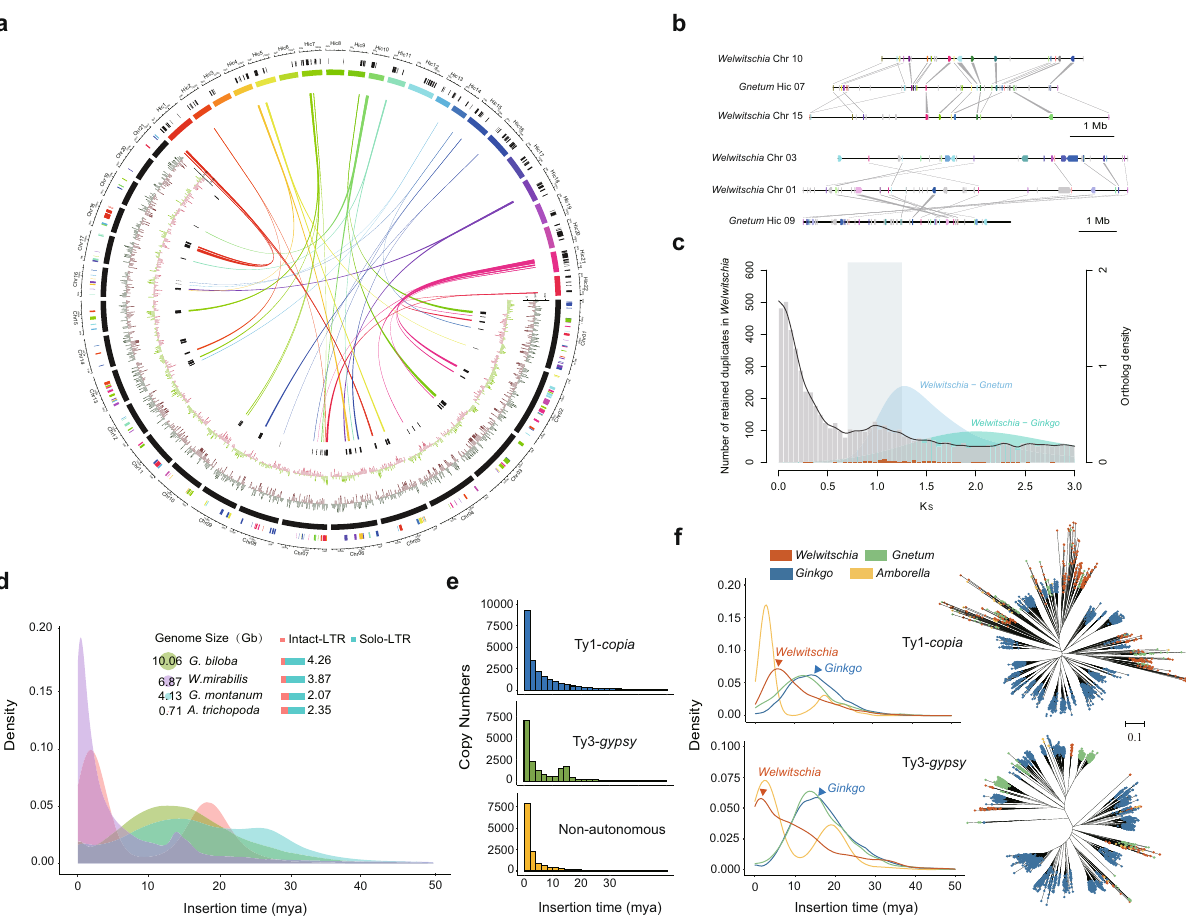
Fig. 2 Genome evolutionary history of Welwitschia . a A circos plot showing the inter-genomic collinearity analysis between the Welwitschia and Gnetum genomes. From outside to inside, each track shows (1) one-to-one orthologous collinear regions between the two genomes with colors showing their orthologs on different chromosomes in the other species; (2) the chromosomes of Welwitschia in black and Gnetum in colors; (3) the coverage of tandem repeats in a 5 Mbp window with green and red bars showing above or below the mean coverage of tandem repeats across the genome for Welwitschia (standard deviation in gray), respectively; (4) the coverage of long terminal repeats (LTRs) in a 5 Mbp window with light green and light red bars showing above or below the mean coverage of tandem repeats across the genome (standard deviation in gray), respectively; and (5) paralogous collinear regions in the Welwitschia genome with at least fi ve anchor pairs. The bands denote collinear regions where one region in Gnetum corresponds to two orthologous regions in Welwitschia . b Two examples illustrating one segment in Gnetum corresponding to two paralogous segments in Welwitschia . Genes in light gray are non-homologs. Genes with the same colors are homologs and homologous genes are connected with dark gray bands when the two segments are alongside. c Distributions of synonymous substitutions per synonymous site ( K S ) for the whole paranome of Welwitschia (light gray histogram and dark gray line). The y axis on the left shows the number of retained duplicates and there is a small peak at K S of 1, which represents a WGD event. The y axis on the right shows the orthologue density between the two species. For one-to-one orthologs between Welwitschia – Gnetum and Welwitschia – Ginkgo (color- fi lled curves of kernel-density estimates) the peaks represent species divergence events and K S values correspond with the degree of orthologue divergence. The K S values for anchor pairs from collinear regions are indicated in orange (left y axis). The pale gray rectangle highlights the K S regions in which the paralogous genes were used for absolute dating. d Estimation of LTR activity showing a recent burst in Welwitschia less than two million years ago (mya). e In this recent burst of activity, the majority of elements responsible were both autonomous (13,893 copies of Ty1- copia and 9,999 copies of Ty3- gypsy ) and non-autonomous LTRs (10,589 copies), with peaks of activity <5 mya. f Heuristic neighbor-joining trees constructed from 3,298 full-length Ty3- gypsy and 2,224 of Ty1- copia sequences from Welwitschia , Gnetum , Ginkgo, and Amborella . There were many more complete elements identi fi ed in Ginkgo (4,237) than in the other species, elements that were likely to have been derived from a peak of activity about 15 mya. A few clades of Welwitschia - derived Ty3- gypsy (131 copies) probably arose from the recent activity at ~2 mya (see e ). Source data underlying Fig. d – f are provided as a Source Data fi